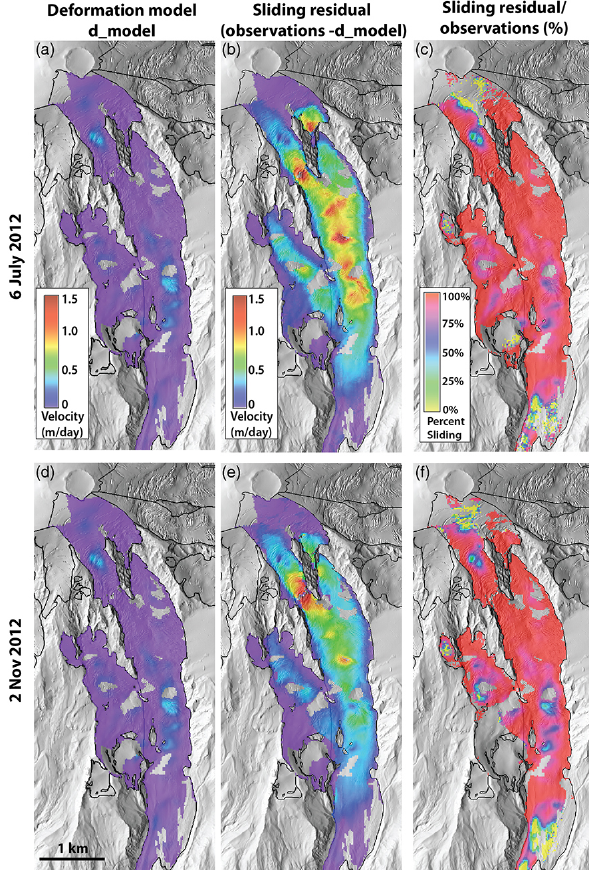
Figure 9. Model results for summer (6 July 2012) and a late fall (2 November 2012) time period for Nisqually and Wilson glaciers. (a, d) Modeled surface velocity for internal deformation; (b, e) slid- ing residual (observed slope-parallel velocity minus the modeled deformation velocity); (c, f) estimate of the sliding percentage (slid- ing residual divided by total slope-parallel velocity).